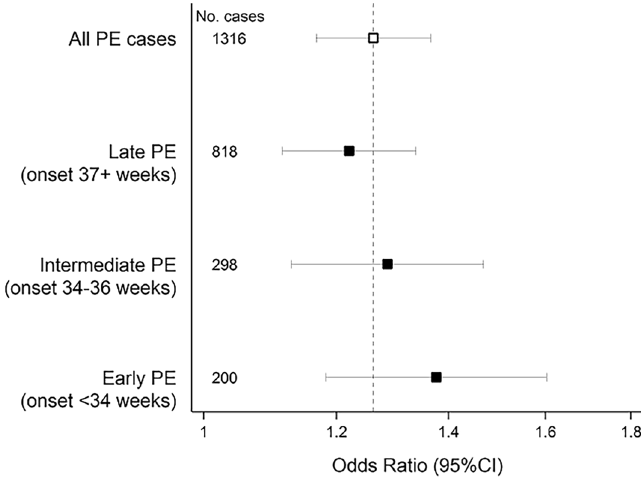
Figure 2. Serum uric acid levels and presence of early, intermediate and late pre-eclampsia in adjusted models* (*Multinomial regression model for early, intermediate and late pre-eclampsia adjusted for maternal age, recruitment centre, ethnicity, recruitment date, multiple pregnancy, smoking, socioeconomic position and infections during pregnancy. Gestational age was not included in the model because this variable defines the sub-outcomes. Results from the logistic model independent of the gestational age of onset is presented for comparison (hollow square). Odds ratios are reported on a logarithmic scale.).